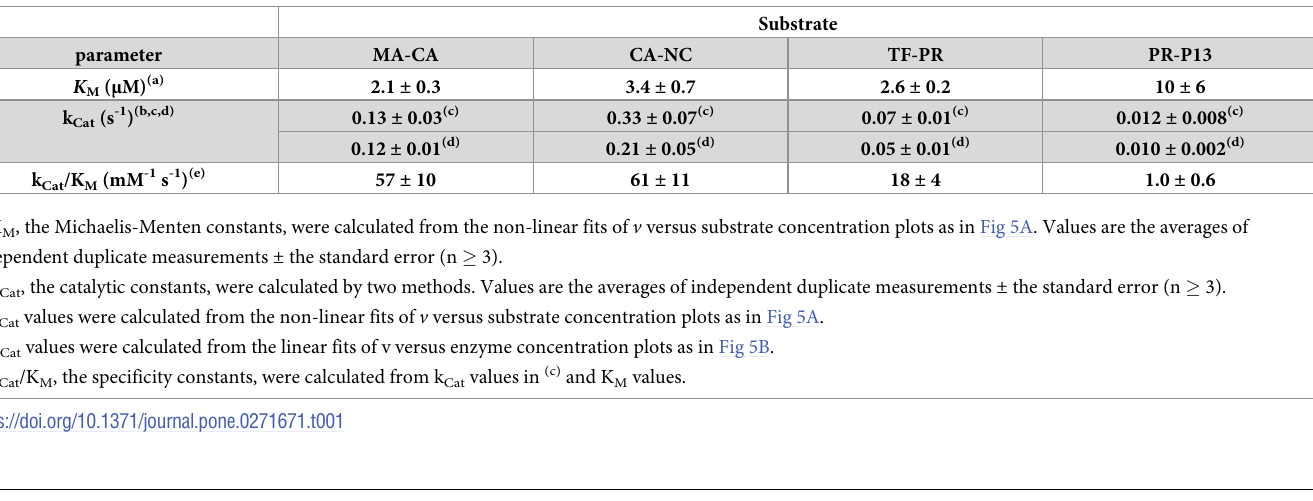
Table 1. Kinetic parameters of BLV-PR with the fluorogenic